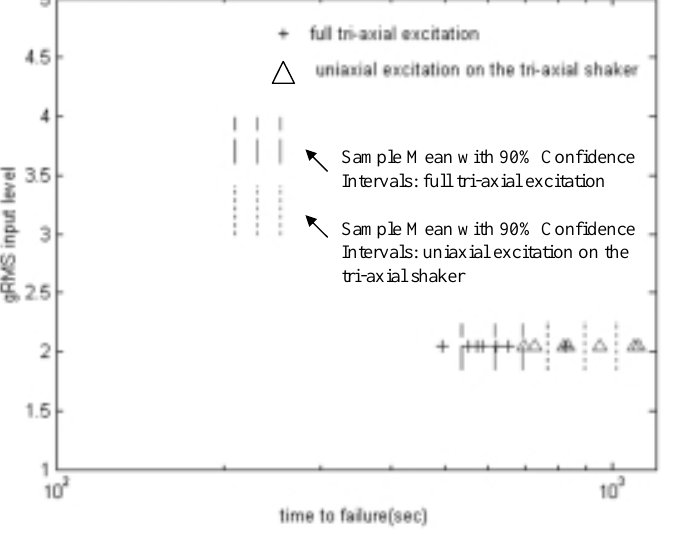
Fig. 12. Uniaxial results on the triaxis shaker versus full tri-axial